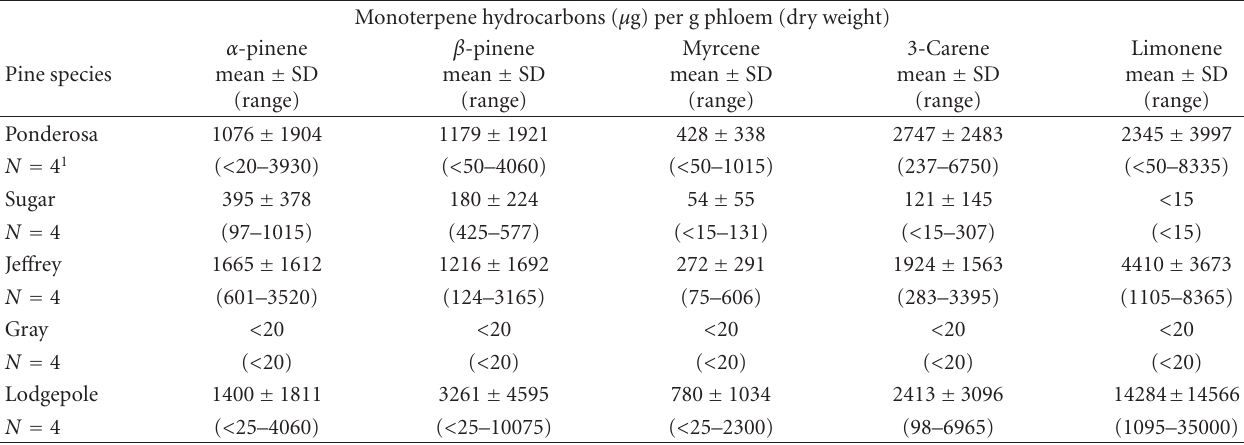
Table 2: Amounts of monoterpene hydrocarbons in phloem samples (15–25mg dry weight) from five species of pine (near Bass Lake, California, USA, 17 October 1986).